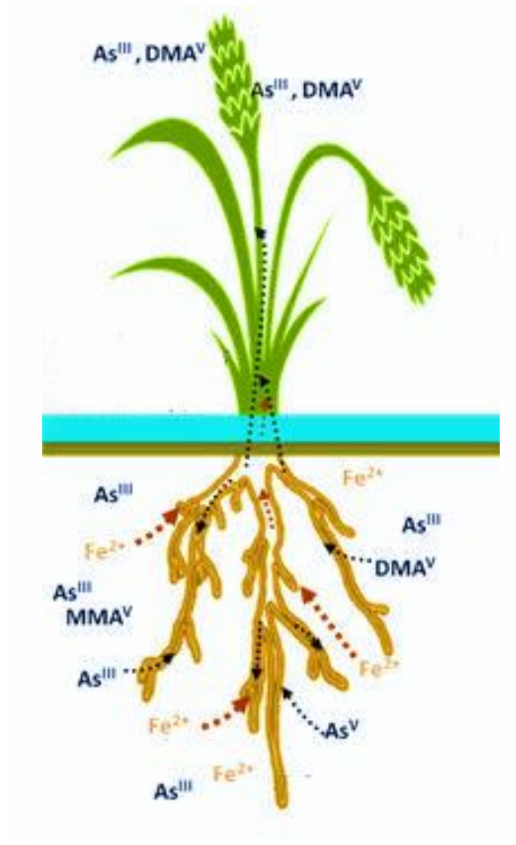
Figure 1. Uptake mechanism of arsenic in paddy plants. Adapted from Zhao et al. [55]. Copyright permission granted by Copyright Clearance